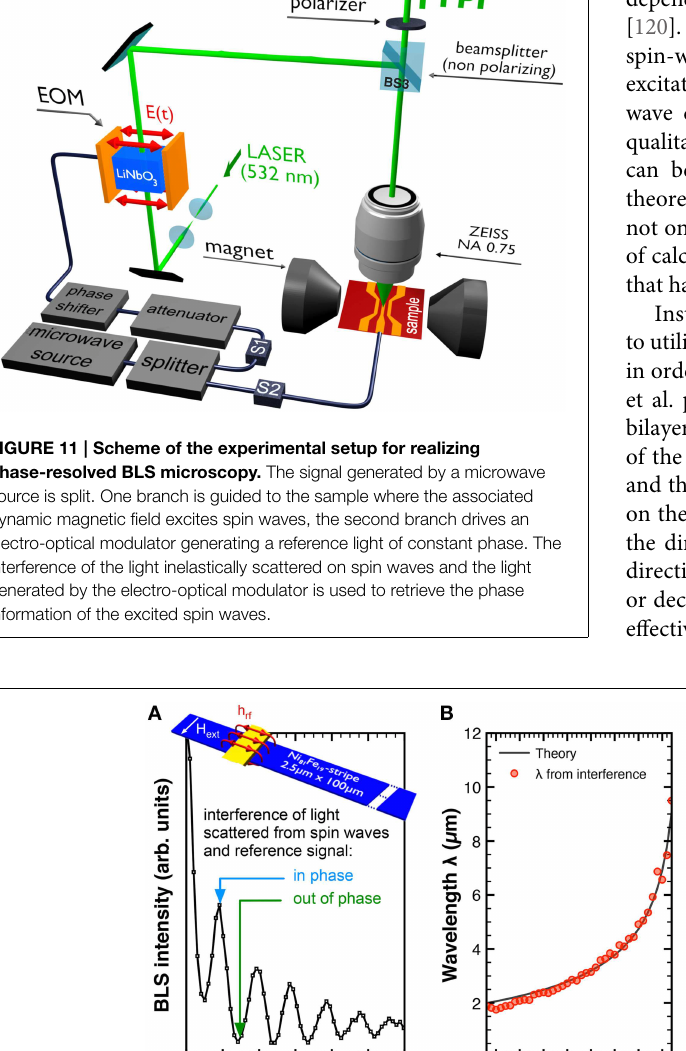
(circles) in comparison with theoretical calculation from the dispersion relation. Taken from Vogt et al. [120]. (C) Top: BLS microscope images of the spin-wave intensity distribution and the phase map in a Cu/Ni 81 Fe 19 -waveguide. Bottom: Interference signal measured for different applied currents in the bilayered waveguide. Taken from Demidov et al.